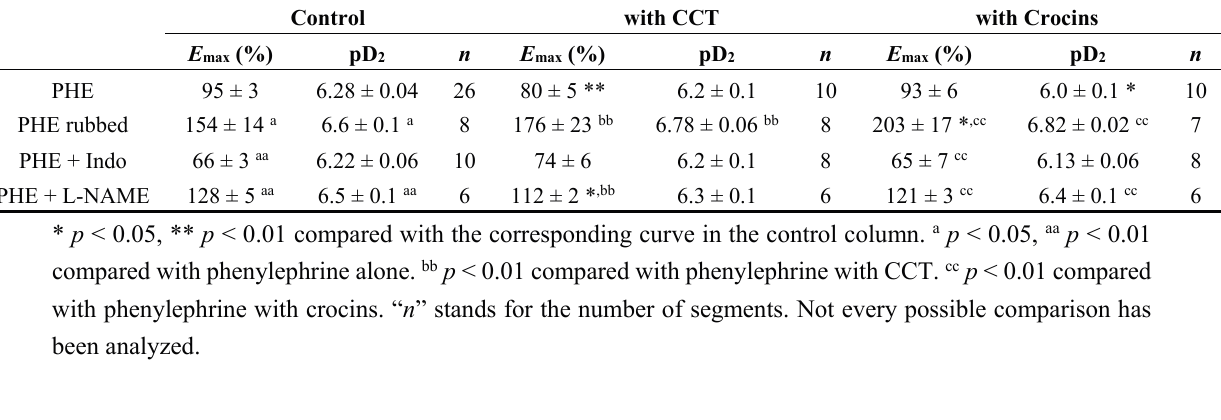
Figure 2. The effect of crocetin (CCT) and crocins on the endothelial modulation of aortic smooth muscle contraction elicited by phenylephrine was assessed by performing a dose-response curve in the presence (panel A ) or absence (panel B ) of endothelium (please note the different scale in both panels). The existence of an intact endothelium is required for CCT, but not for crocins, to diminish phenylephrine responses. * p < 0.05, ** p < 0.01 compared with the control curve. Table 2. Acute effects of saffron carotenoids on vascular responses. Control with CCT with